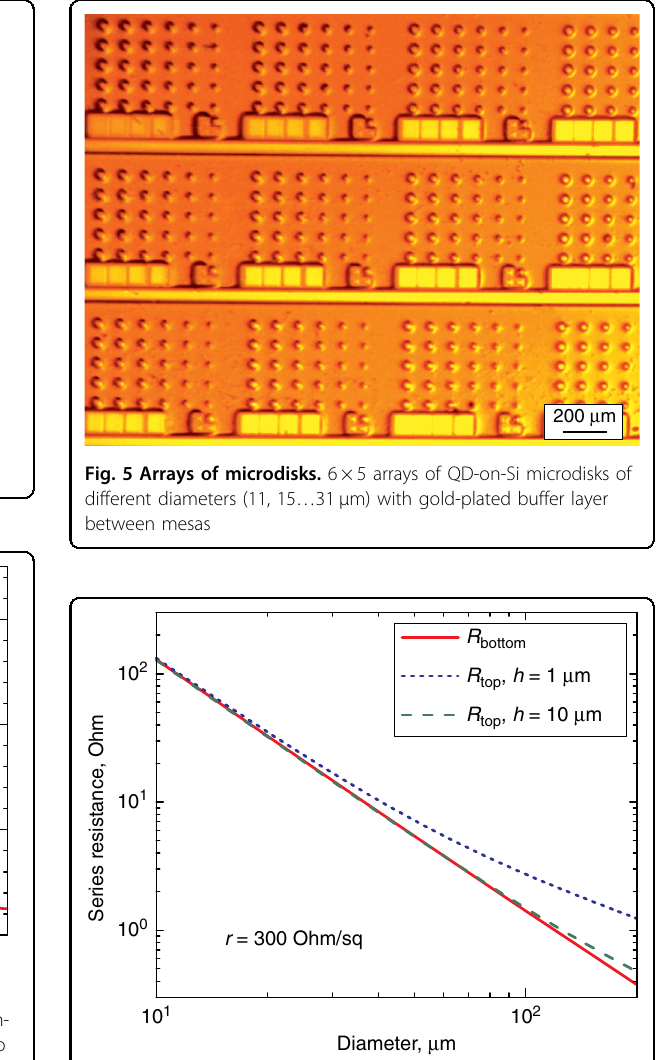
Fig. 6 Impact of the n -contact location. Calculated microdisk resistance for conductive R bottom (bottom-contact; solid line) and non- conductive R top (top-contact; dashed and dotted lines) substrate with the conductive buffer of thickness